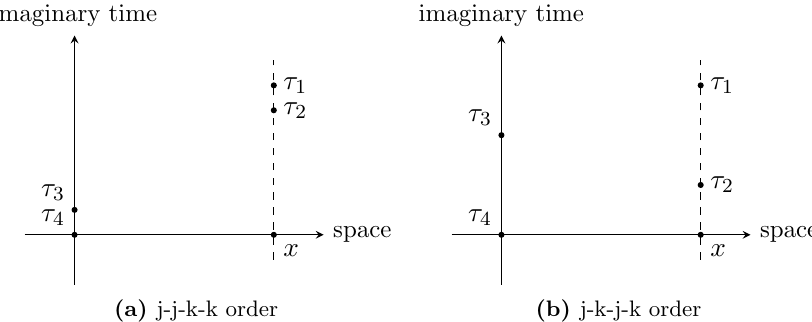
Figure 5. Two regions of the four-point function are illustrated. Factorization in the con(cid:12)guration at left gives the propagating bilocal (cid:12)elds. The con(cid:12)guration at right can be continued to the OTOC which diagnoses